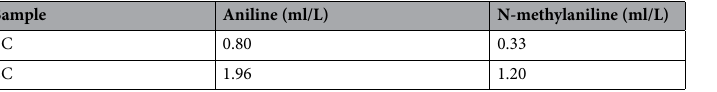
Table 3. Aniline and N-methylaniline in toluene after the extraction of the leucoindigo solution. The concentrations are referenced to the toluene solution.